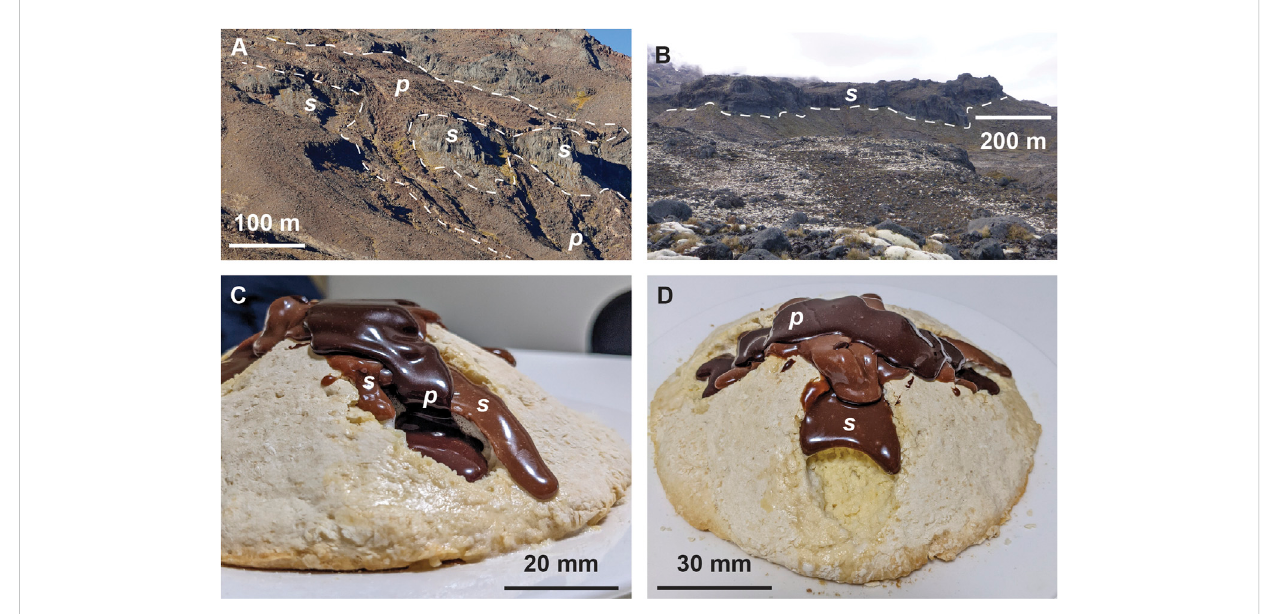
FIGURE 4 Comparison of real lava fl ows at Mount Ruapehu and experimental products. (A,C) Post-glacial lavas (p) fl owed over and around older syn-glacial lavas (s). (B,D) Thick and wide syn-glacial lavas (s) were impounded by glaciers within valleys. Photograph (A) was provided by Dougal